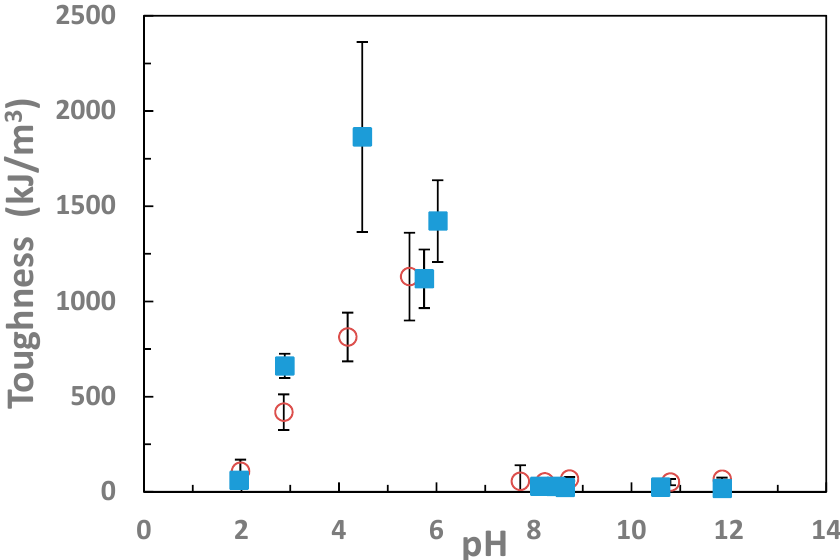
Figure 4. Hydrolyzed IPN toughness increased at intermediate pH values. The toughness at the intermediate pH is much greater than at the uncomplexed state. IPNs of PAAm/PNVF and PNVF/PAAm were partially hydrolyzed to PVAm/PAAc (blue closed symbols) and PAAc/PVAm (red open symbols).